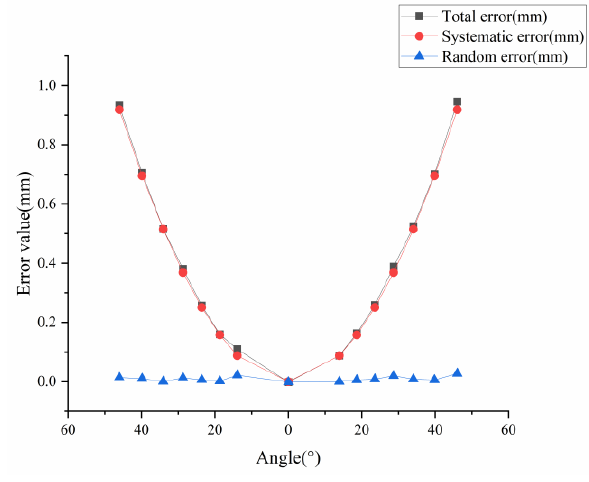
Figure 13. The error of the z coordinate at different measuring angles. Table 6. Measurement results of the measurement position experiment.